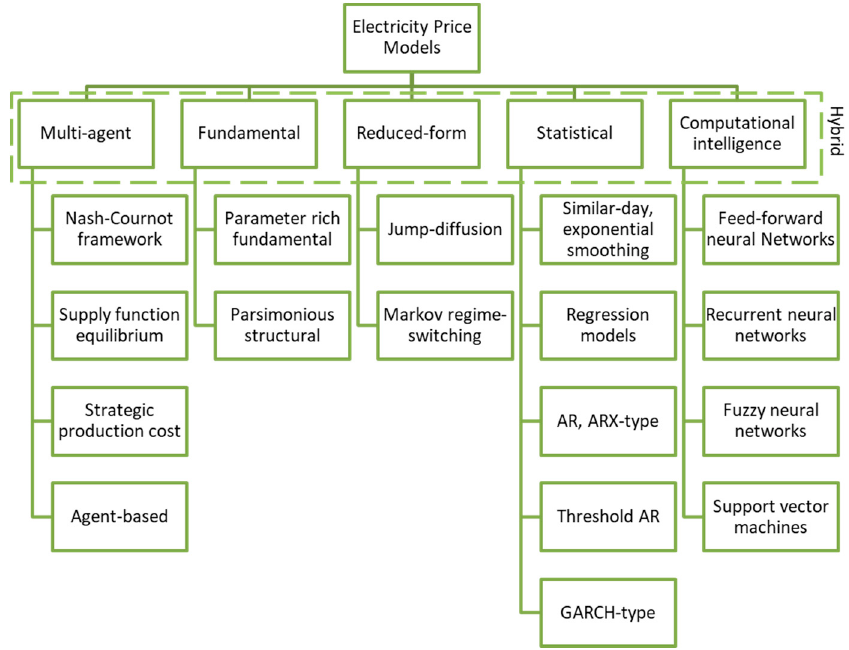
Figure 1. Taxonomy of electricity price forecasting approaches based on [9].